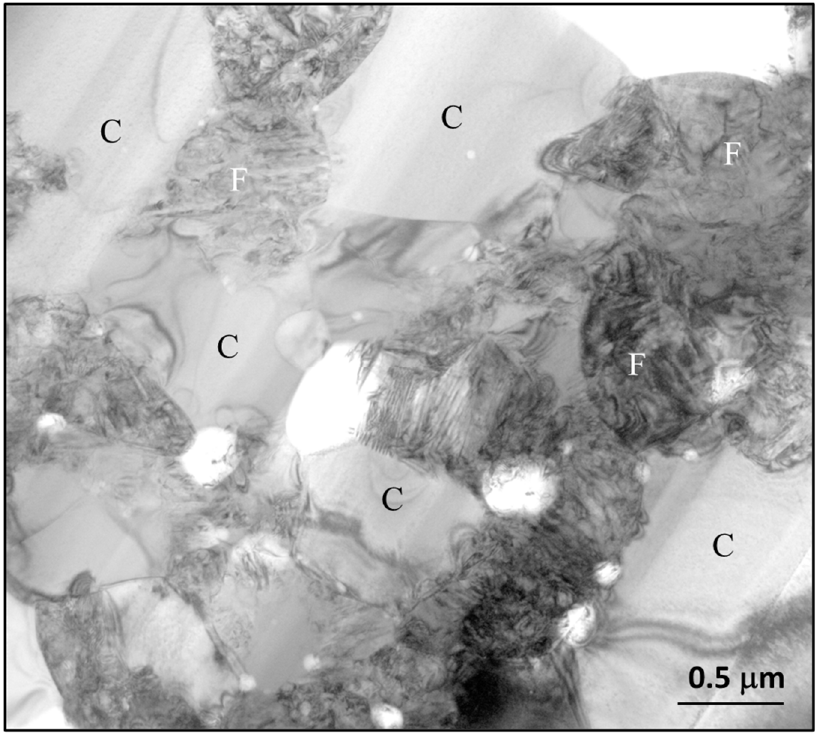
Figure 7. TEM image of cubic clear (C) and tetragonal “faulted” (F) submicron YSZ grains in the TBC.